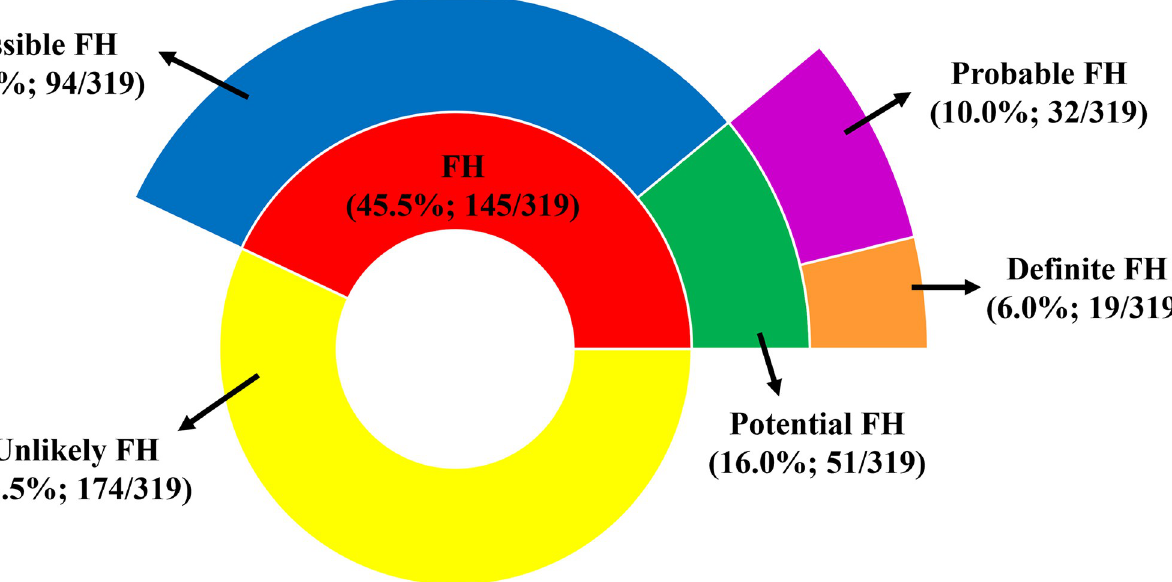
PLOS ONE | https://doi.org/10.1371/journal.pone.0273896 September 2,